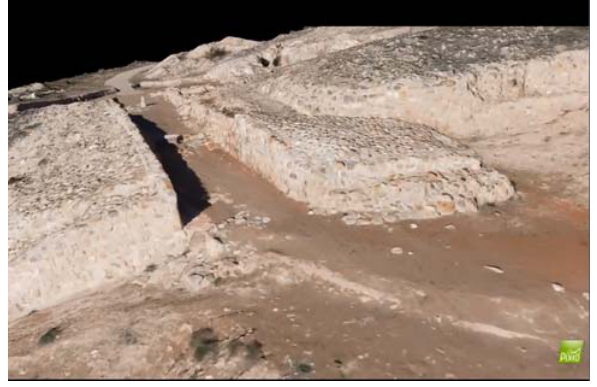
Figure 14. Frame from a walkthrough movie generated from the 3D model of the Gate (created with Pix4D).